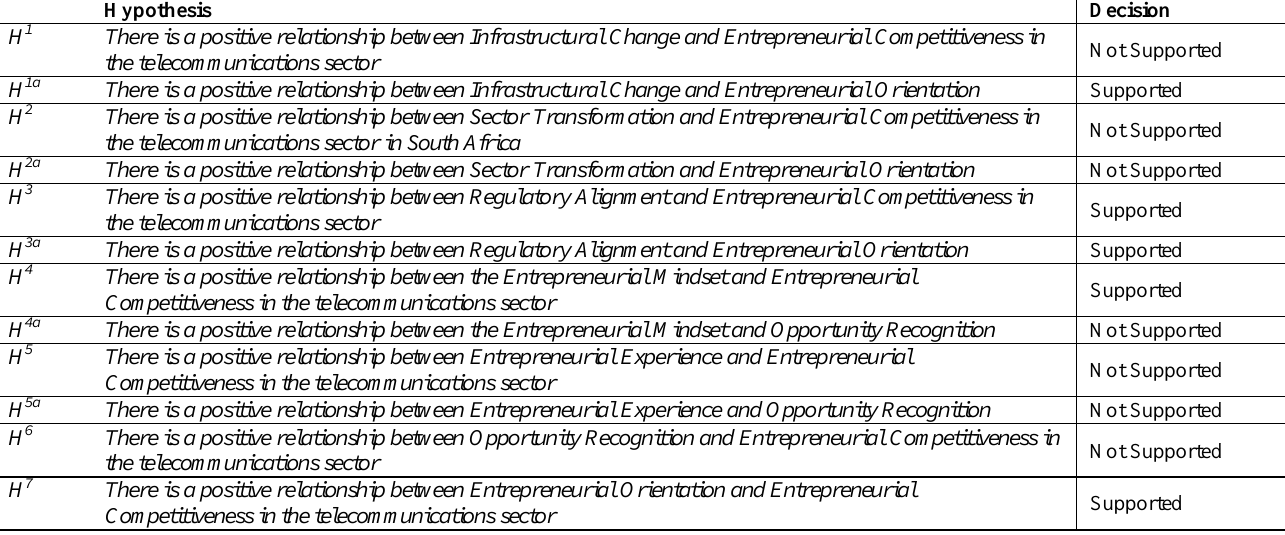
Table 6: Summary of the hypotheses tested in the revised model Hypothesis Decision H